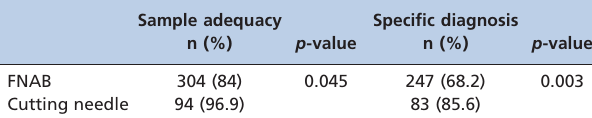
Table 1 - Rates of biopsy sample adequacy and specific diagnosis.